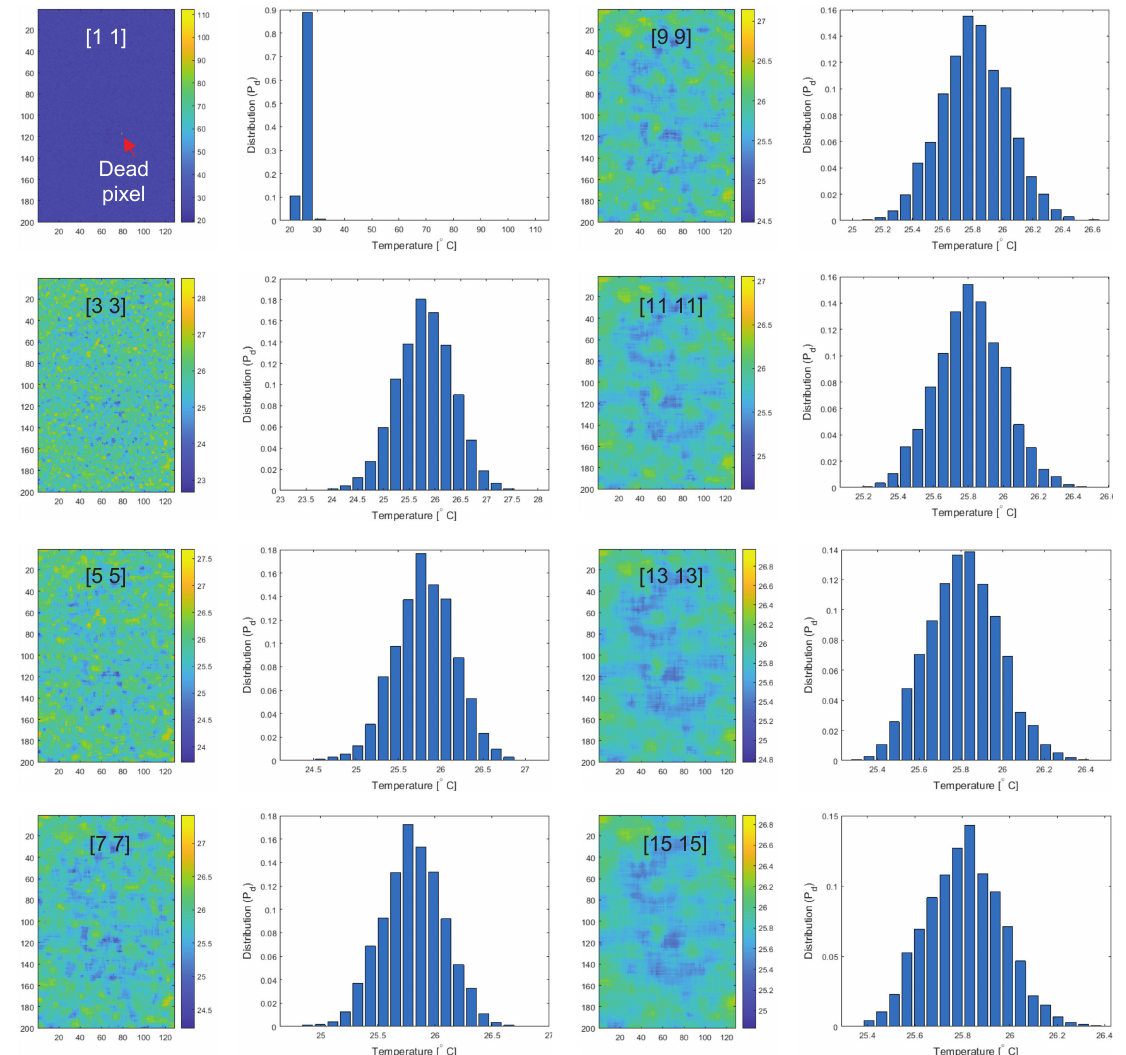
Figure 18. Spatial effects of 2D median filter size and histogram